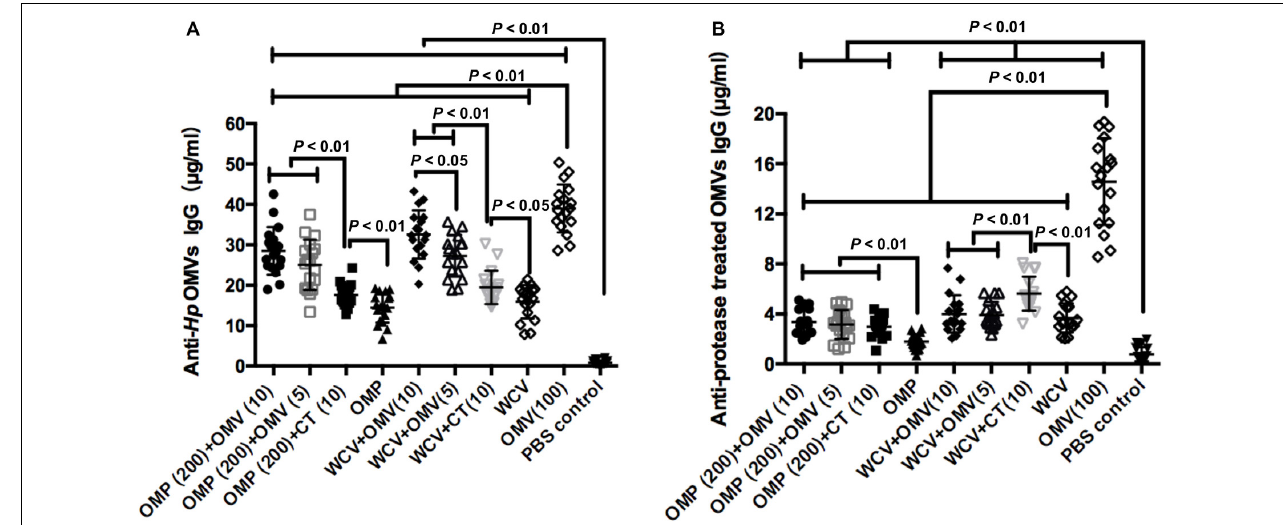
FIGURE 3 | Concentrations of anti- Hp OMVs IgG (A) and protease treated OMVs IgG (B) from mice of all experimental groups were determined quantificationally by ELISA at week 8. The results of IgG analysis are expressed as means ± SD. The means were compared using the least significant difference test. P < 0.05 and P < 0.01 represents the difference between the related groups.